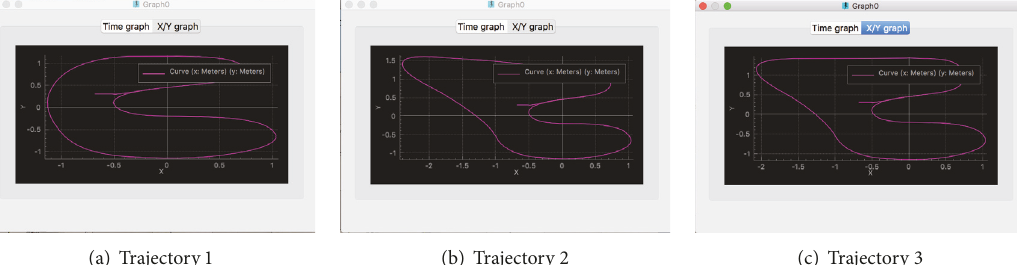
Figure 8: Different trajectories of the line tracing robot.